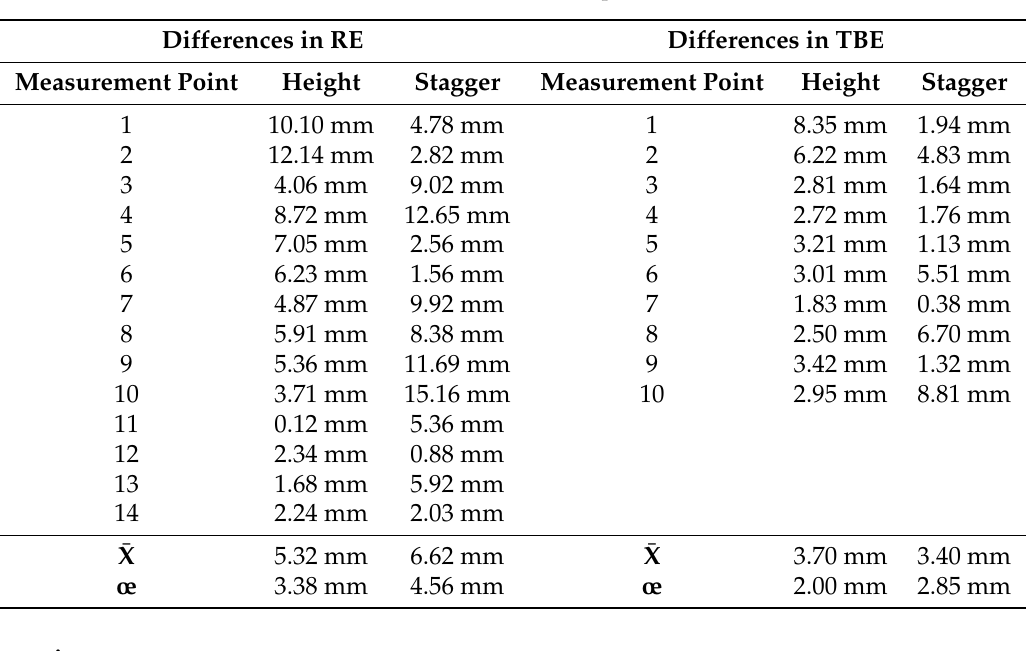
Table 1. Differences between compared methods.